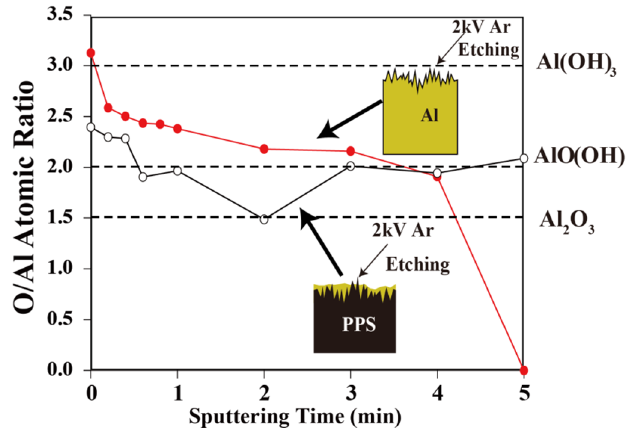
Fig. 8. O/Al atomic ratios calculated using the Al 2 p and the O 1 s integral peak intensities as a function of sputtering time before (Al surface) and after (PPS/Al5052 interface) the